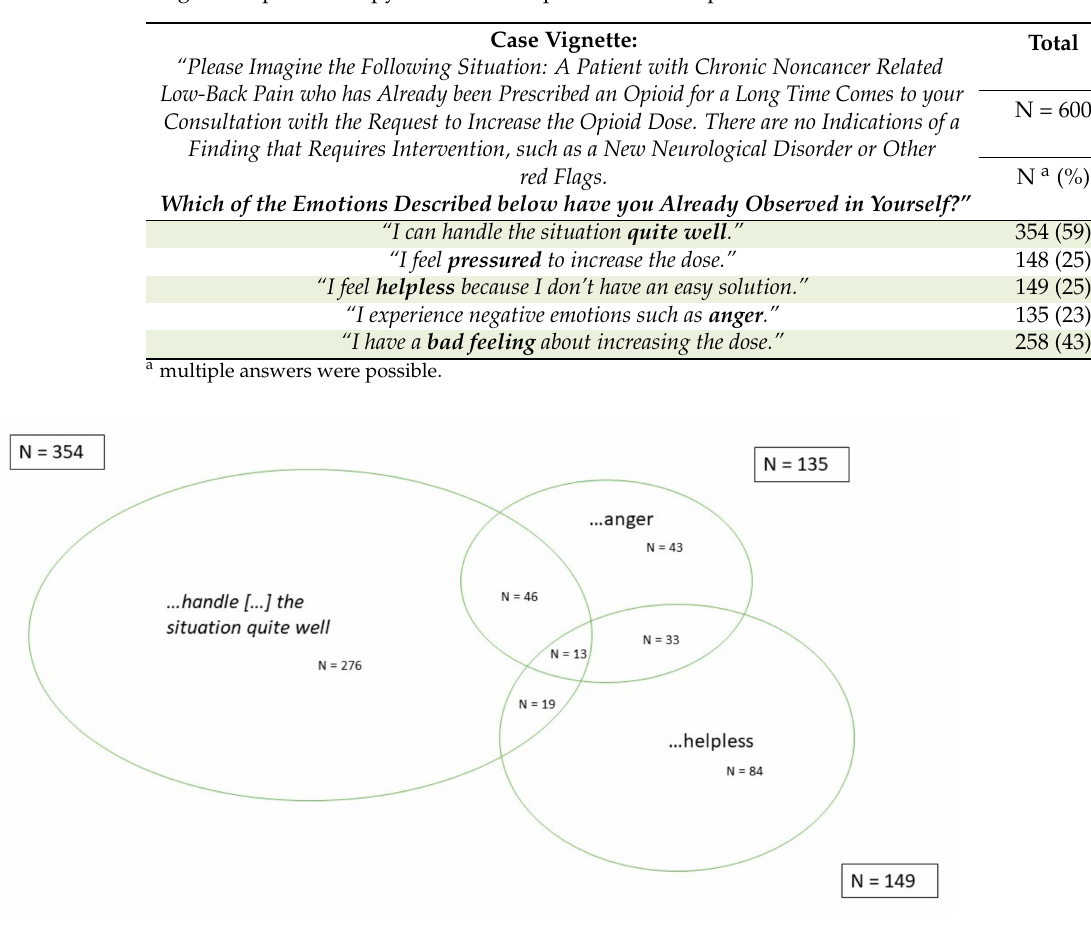
Figure 2. A selection of physician self-reported emotional reactions to a patient’s desire to increase opioid dosage and their